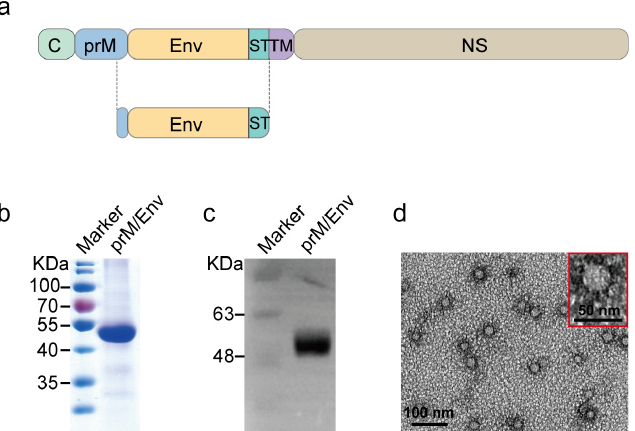
Figure 1. Construction and characterization of Japanese encephalitis virus (JEV) virus-like particle (VLP). ( a ) Schematic design of JEV VLP vaccine candidate. ( b ) purified recombinant prM/Env protein was analyzed by SDS-PAGE. ( c ) Immunoblot analysis of recombinant prM/Env protein with polyclonal antibodies against JEV. ( d ) VLP shape and size were tested by electron microscopy with negative staining method. spherical VLP size was 20–30 nm in diameter and mainly in ~30 nm. Scale bar: 100 nm, 50 nm.